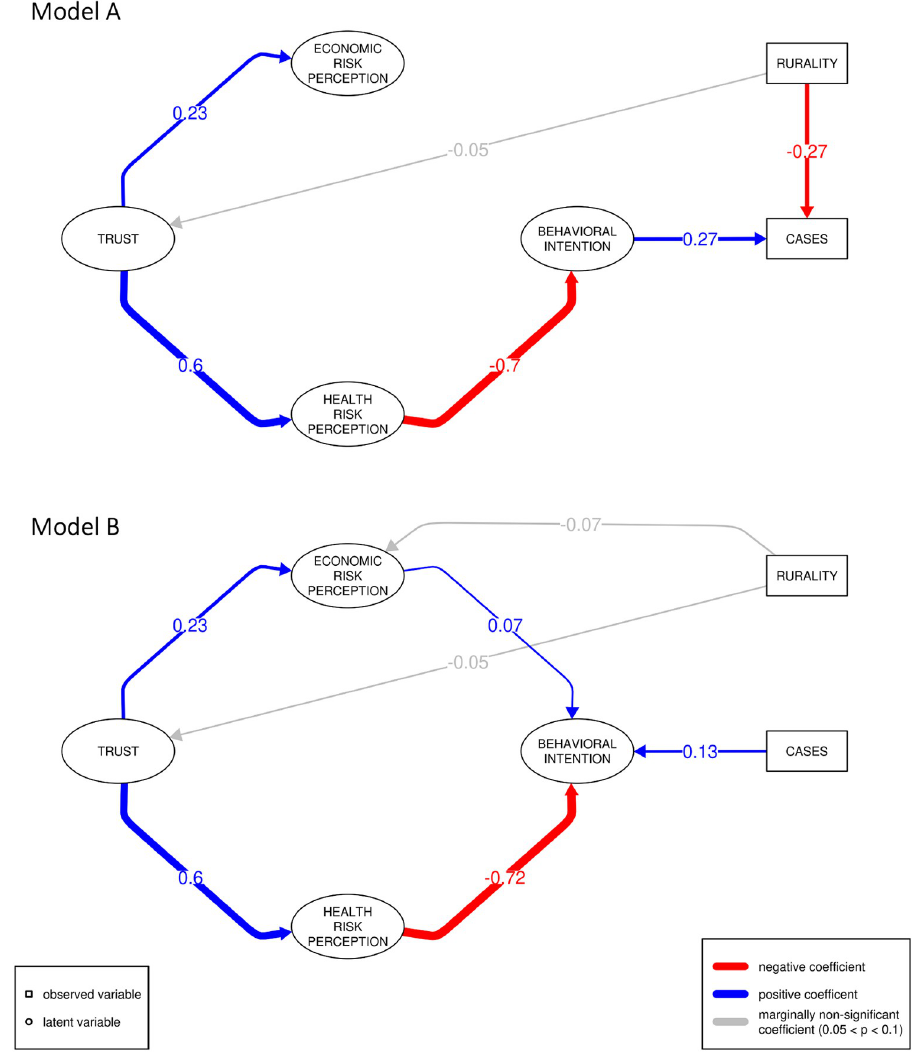
Fig 2. Best supported social cognitive model with A and B types. The results of our SEM show that the model where trust influences perceived health risk which in turn alters behavioral intention is the best of our causal hypotheses. Model A shows behavioral intentions affecting disease burden, and Model B shows the effect of disease burden on behavioral intention. In model A , rurality has an indirect effect on disease burden, with a negative effect on trust ultimately leading to increased disease burden. Only pathways that are supported with p < 0.1 are